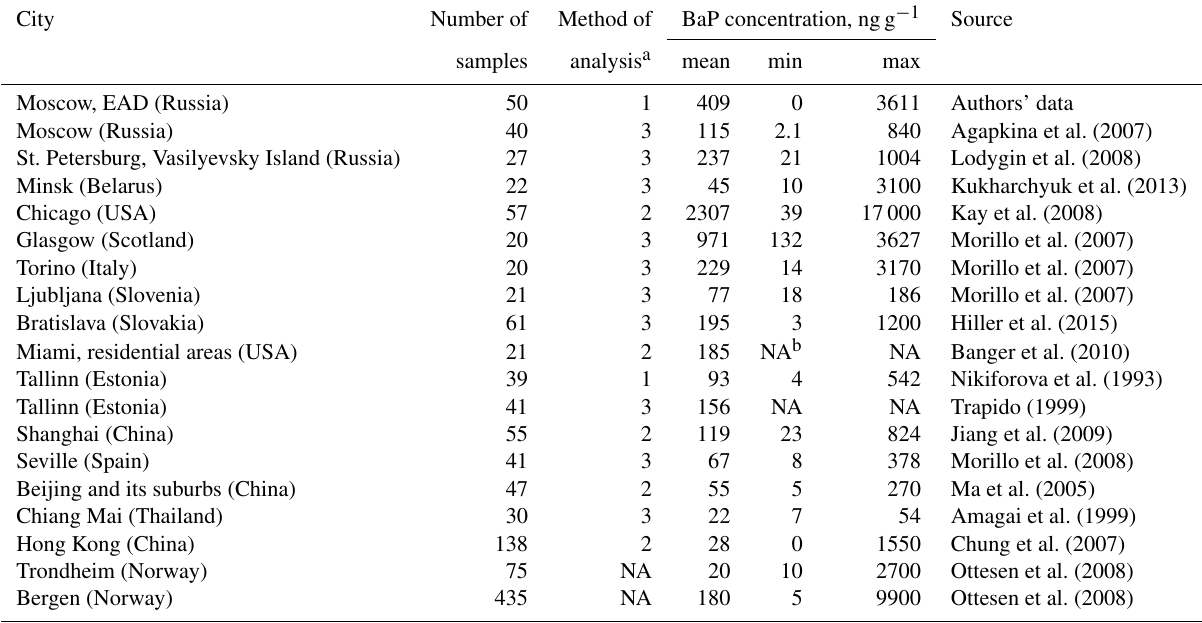
Table 2. BaP content in the topsoils in some cities of the world. City Number